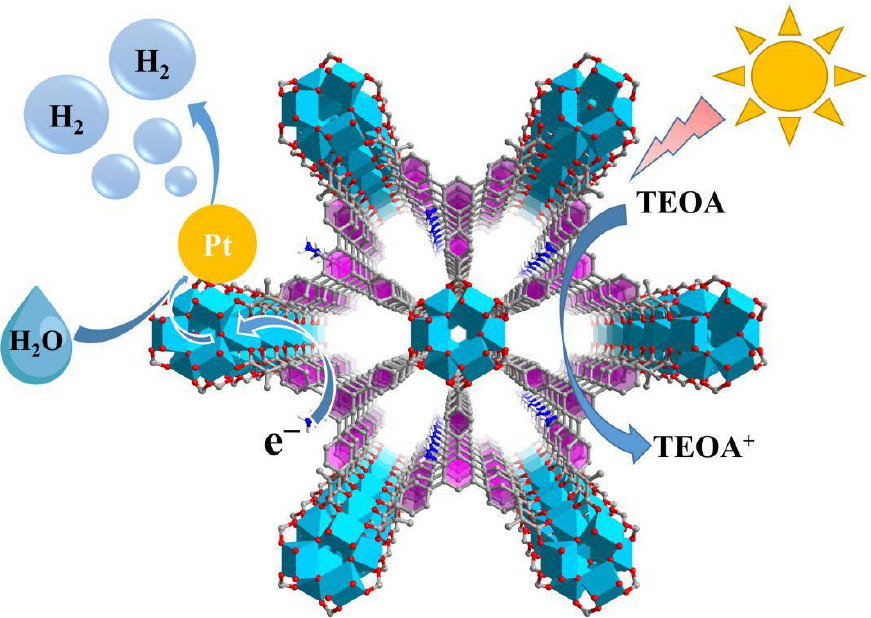
Figure 8. Proposed photocatalytic hydrogen production mechanism over NH 2 -ZSTU-2 under visible light irradiation.